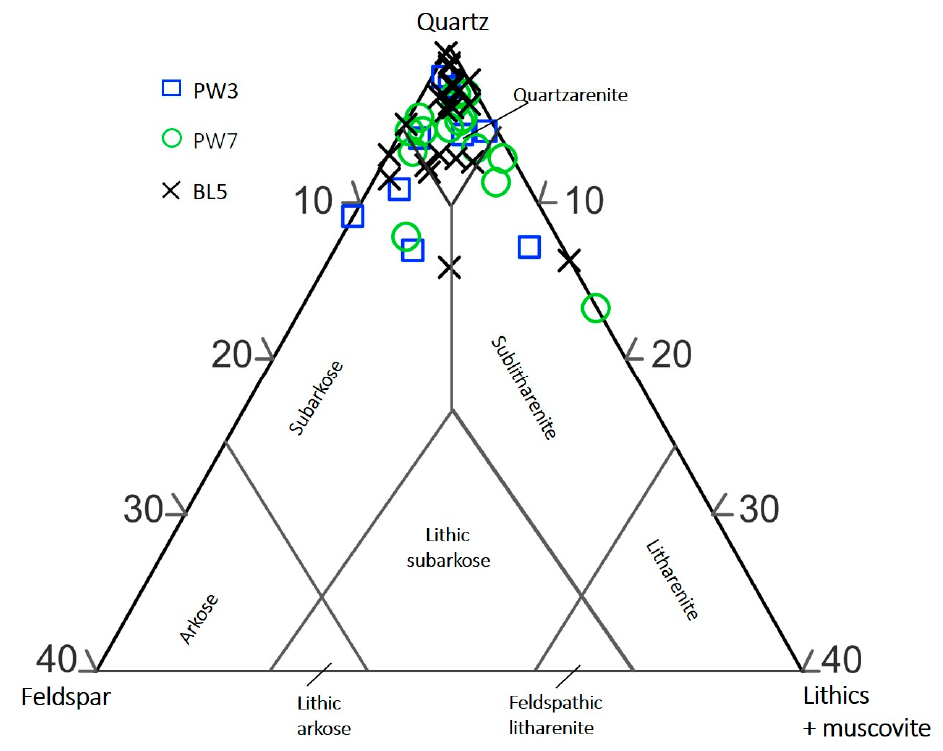
Figure 6. Modal composition for the Corallian sandstones, after McBride [37] showing predominantly quartz arenite lithology.